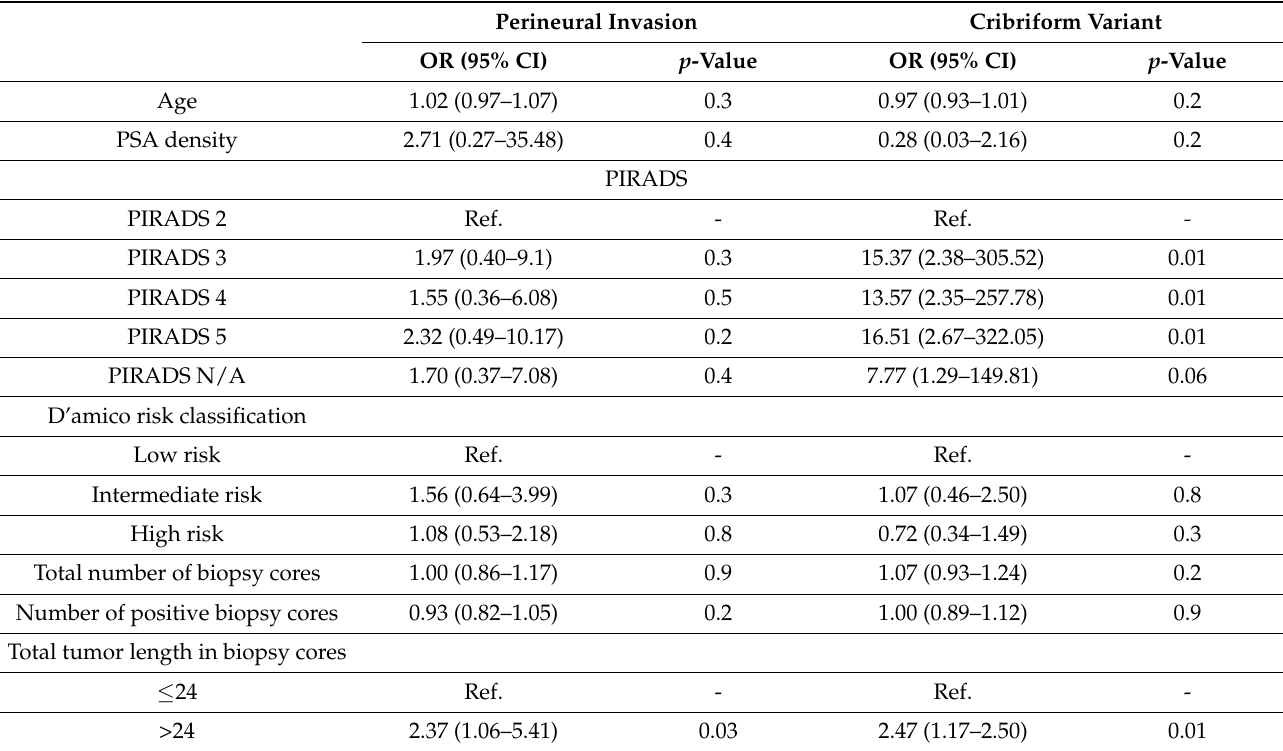
Table 4. Weighted multivariable-adjusted logistic regression analyses predicted the effect of cribri- form variant and perineural invasion presence within D’Amico risk classification of PCa patients,